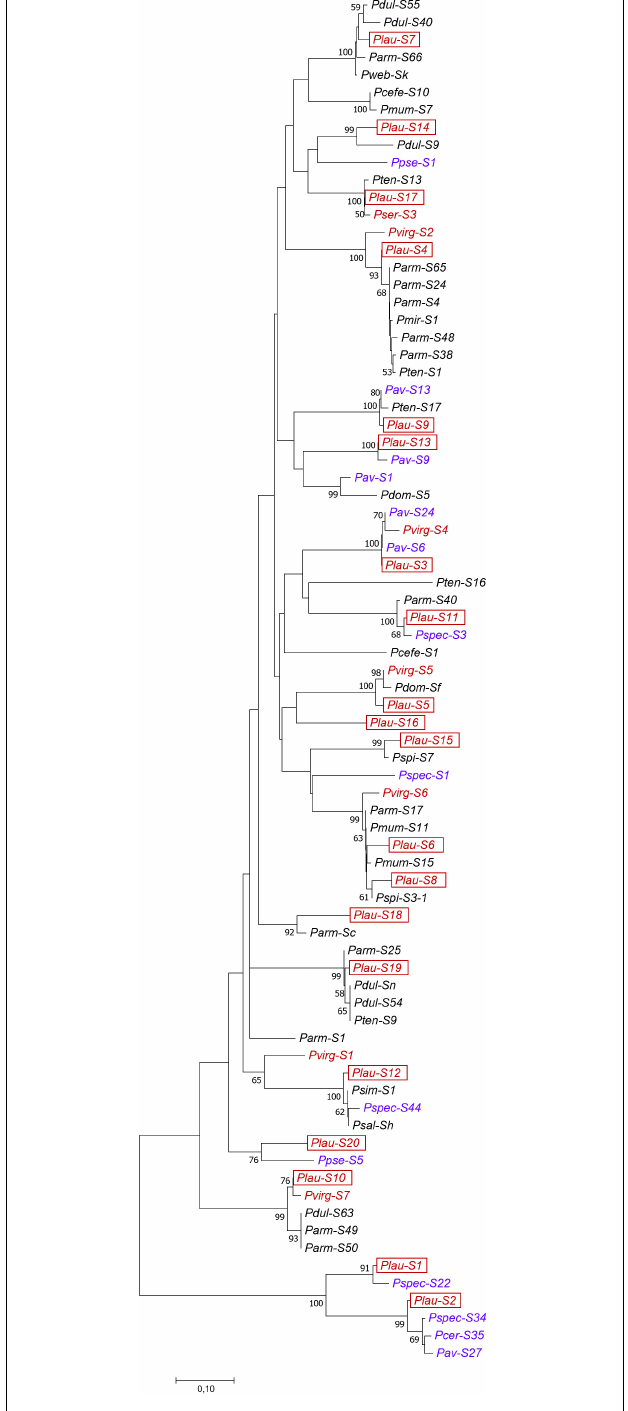
FIGURE 4 | Phylogenetic tree of the new P. laurocerasus and other Prunus S -RNase sequences constructed using the Minimum Evolution method with the indication of the bootstrap values (%, n = 1,000). Black, blue, and maroon colors represent distinct groups of Solitary, Corymbose, and Racemose groups within Prunus , respectively. The labels of novel cherry laurel S -alleles are framed. The accession numbers of the sequences used in the analysis can be found in Supplementary Table 3